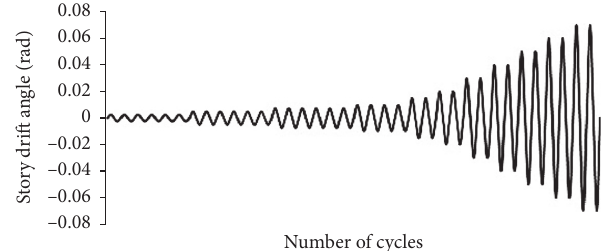
Figure 9: Loading history [38].